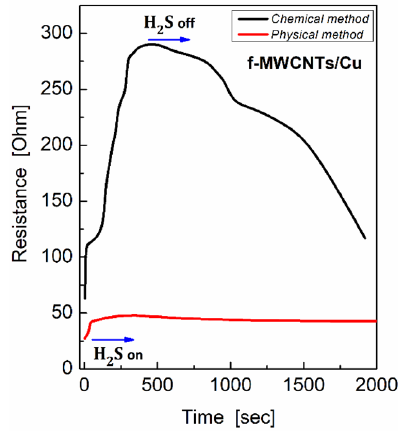
Figure 6. Sensitivity of the f ‐ MWCNTs/Cu nanocomposites prepared by physical and chemical deposition methods.